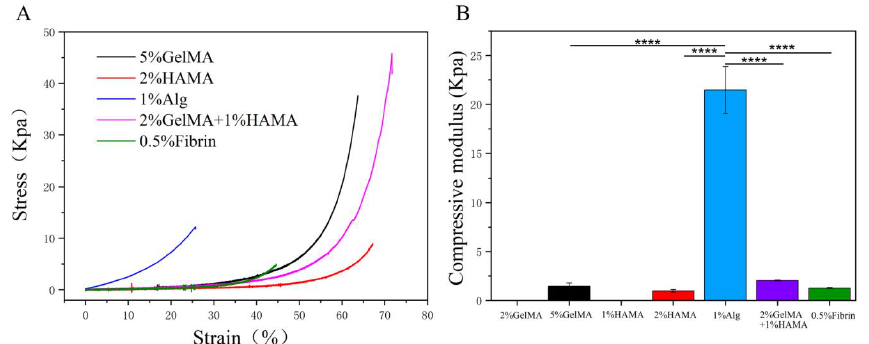
Figure 2. Evaluating the mechanical properties of the low concentration hydrogels . ( A ) Stress – strain curves for hydrogels under compression. ( B ) Corresponding compressive moduli of hydrogels. ****: p < 0.0001.